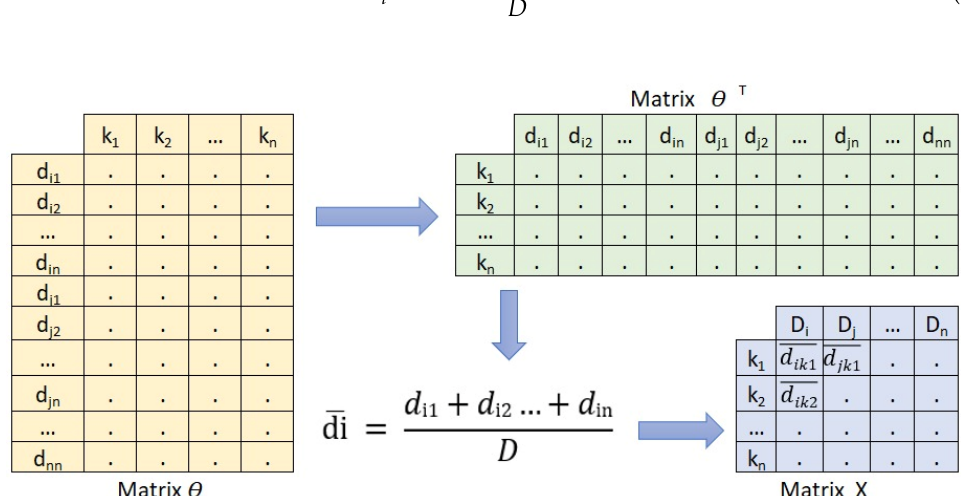
Figure 7. Process of obtaining the X matrix for HJ-biplot.